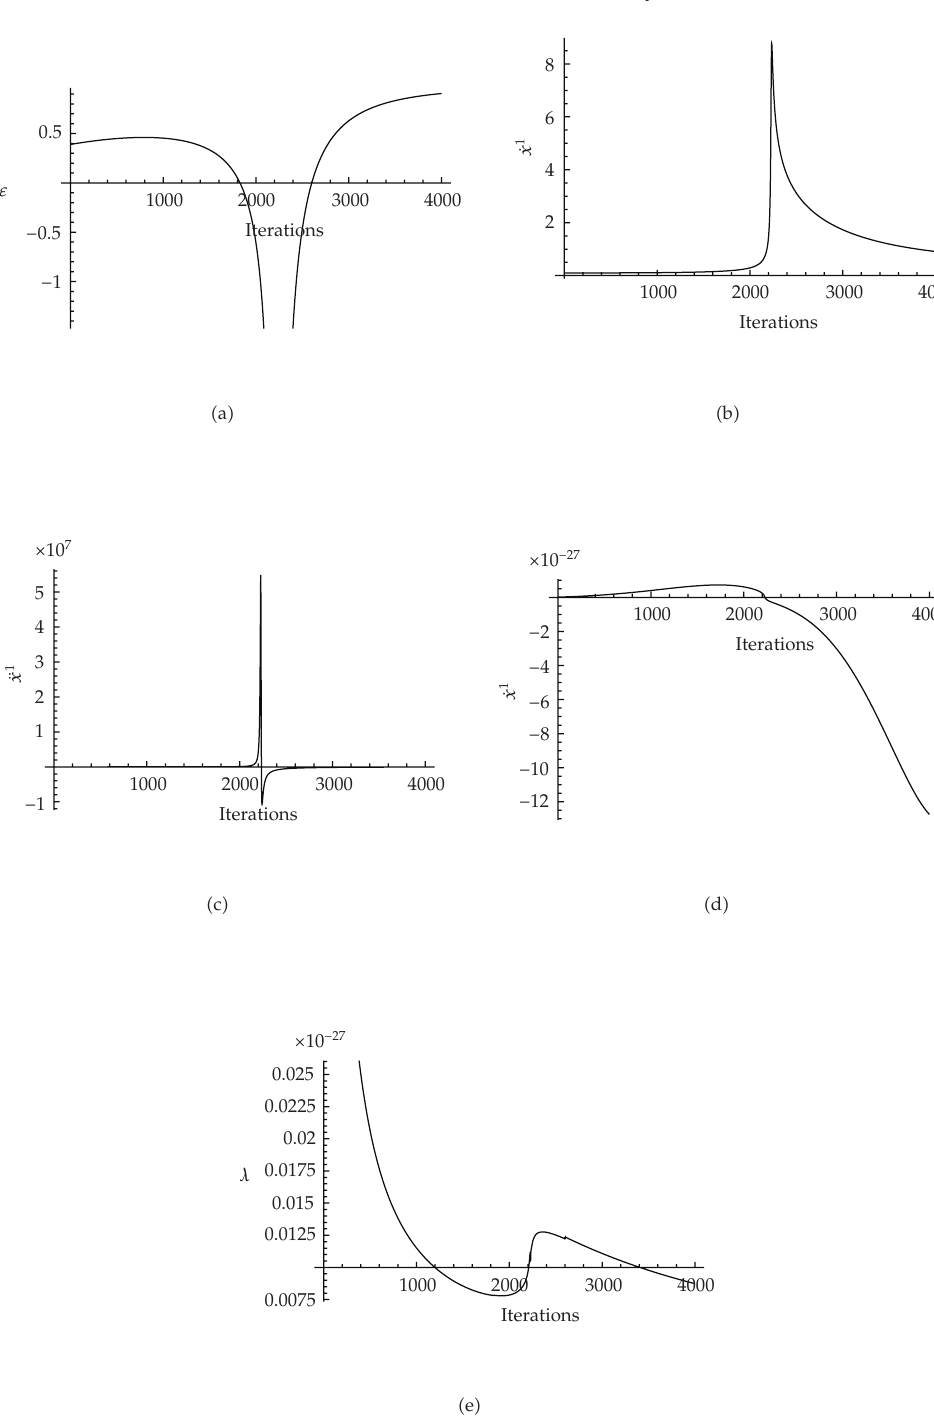
Figure 10: (cid:6) a (cid:7) ε during the first loop cycle. (cid:6) b (cid:7) The ˙ x 1 velocity during the first loop cycle. (cid:6) c (cid:7) The ¨ x 1 acceleration during the first loop cycle. (cid:6) d (cid:7) The e ff ective mass M (cid:6) ε, ˙ ε (cid:7) during the first loop cycle. (cid:6) e (cid:7) The Lyapunov exponent during the first loop